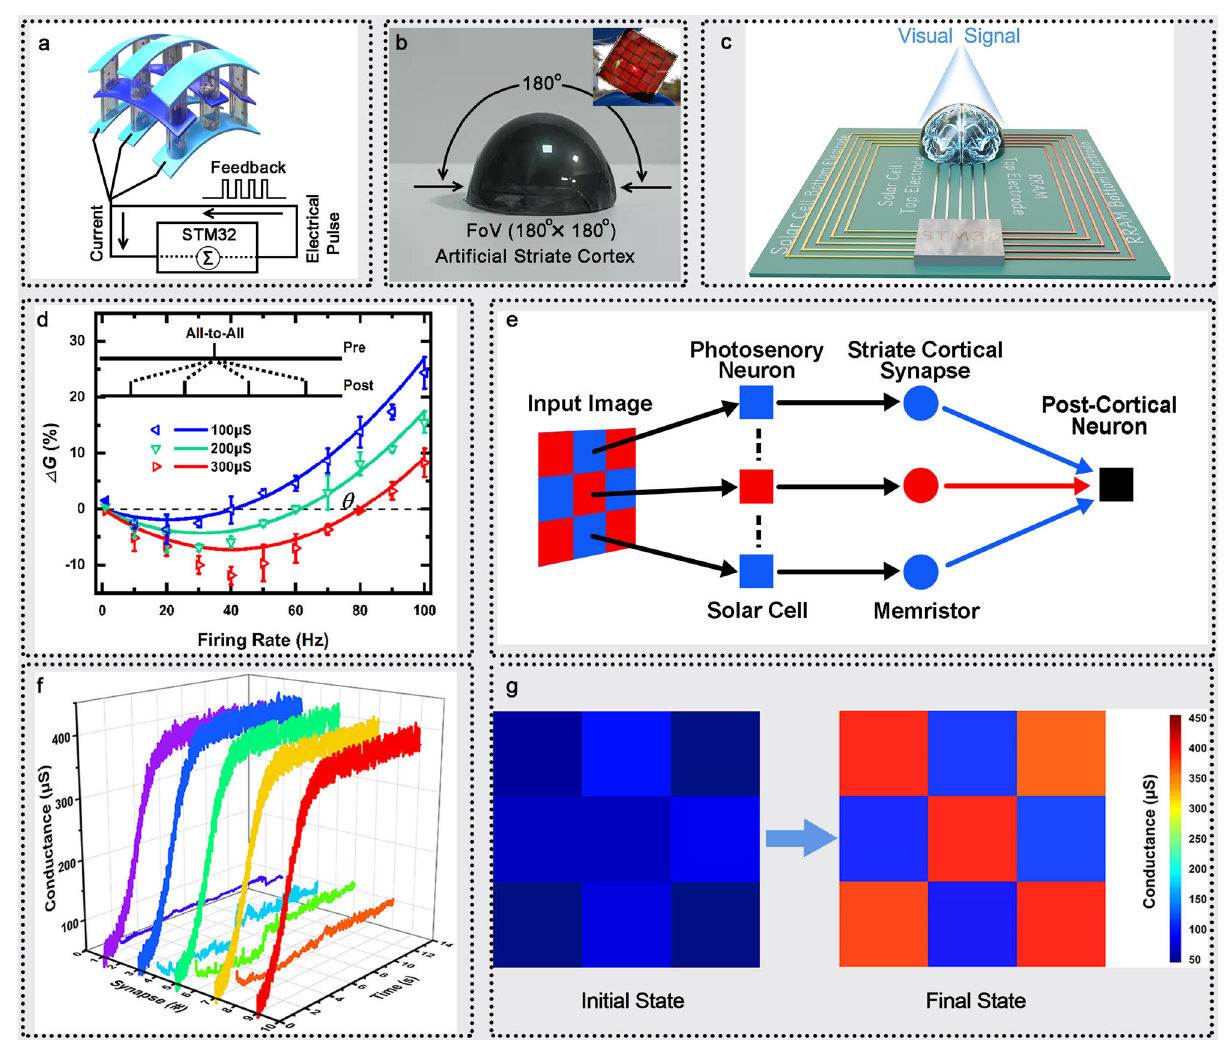
Fig. 4 | BCM learning rule for pattern learning based on device-level arti fi cial striate cortex. a The schematic illustration of arti fi cial striate cortex and the postsynaptic electric circuit design. b The optical images of hemispherical-shaped arti fi cial striate cortex and the fl exible array glowing as sunlight passes through it (insert). And the dimension of the array is 3cm × 3cm with the electrode width of 1000 μ m, where the large array size is limited by the size of sub-solar cell for